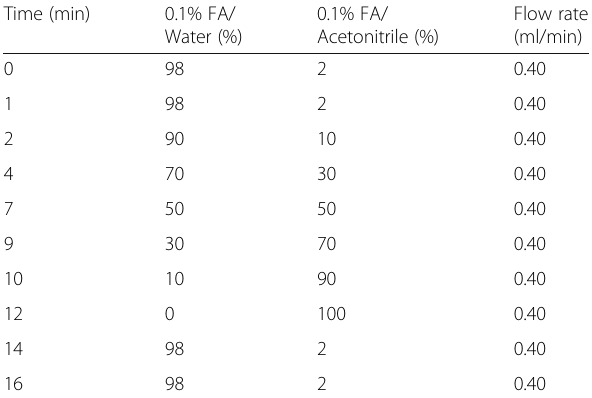
Table 1 Solvent gradient for the analysis fucoxanthin in L.